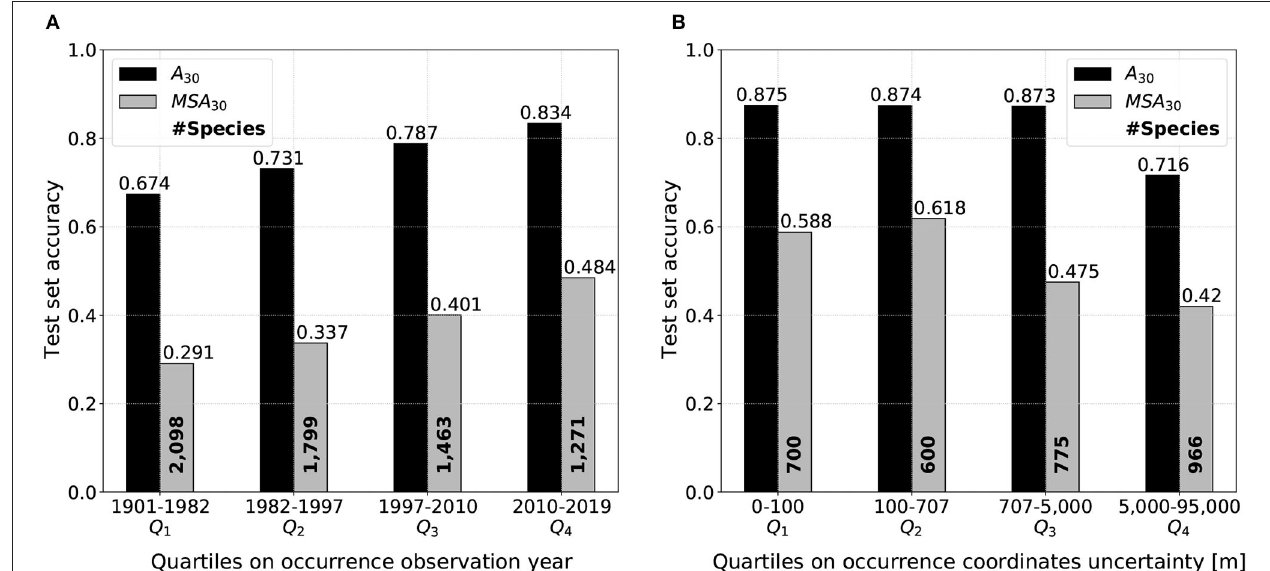
FIGURE 11 | Model performances on the test set divided by quartiles Q i on (A) occurrence observation year and (B) occurrence coordinates uncertainty. The test accuracy is higher on more recent observations and on observations with reasonably low coordinates uncertainty.